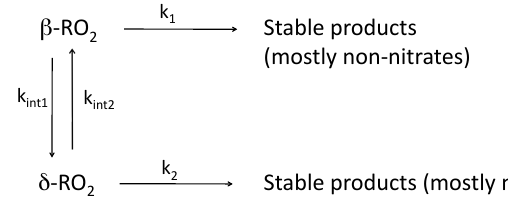
Fig. 4. Schematic of the relationship between the interconversion of peroxy radical isomers and nitrate yields.